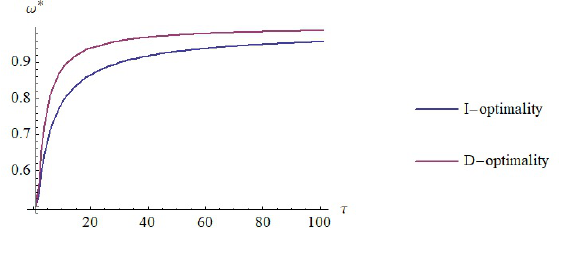
Figure 1. Minimax D - and I -optimal weights at point x = 0 for ψ ∈ Ψ 1